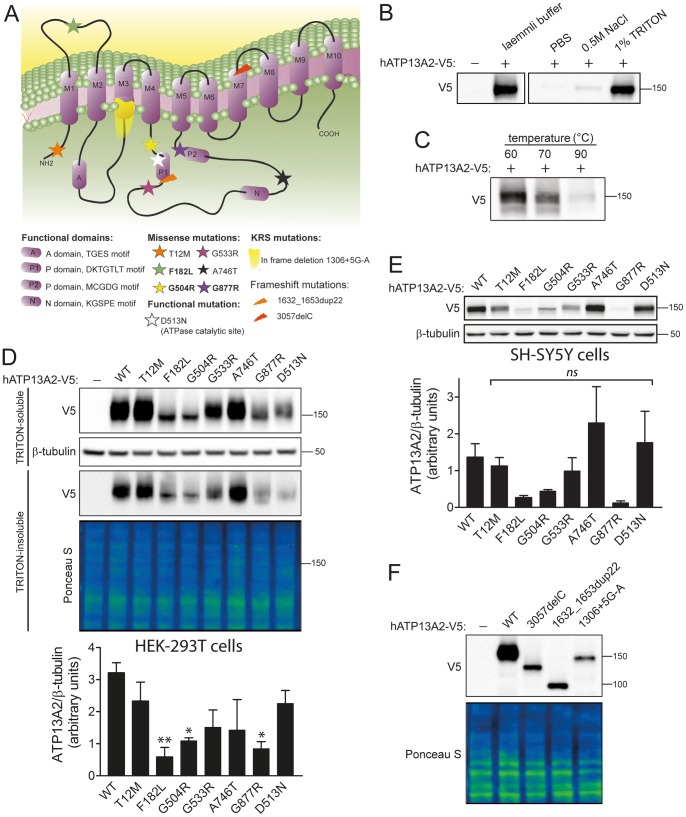
Disease-associated mutations reduce the steady-state levels of ATP13A2 protein. A
, Predicted domain topology model of human ATP13A2. Wild-type (WT) protein consists of ten transmembrane-spanning domains. The second intracellular loop contains the predicted catalytic ATPase domain comprising four functional domains (A, actuator domain; P1, catalytic phosphorylation site domain; P2 and N, nucleotide binding domains). Locations of disease-associated missense mutations are indicated by stars with homozygous variants in bold. KRS frameshift mutations are indicated by orange and red arrows, with an in-frame exon skipping mutation shown by yellow shading. B, Western blot indicating the buffer solubility of V5-tagged human ATP13A2 transiently expressed in HEK-293T cells. C, Western blot revealing the effect of increasing temperature on the solubility of V5-tagged human ATP13A2 in cell extracts obtained by lysis in 1% Triton X-100 buffer. D, Triton-soluble or Triton-insoluble (RIPA-soluble) fractions derived from HEK-293T cells transiently expressing WT or mutant V5-tagged human ATP13A2 were probed with anti-V5 antibody to monitor the steady-state levels of ATP13A2, or with β-tubulin antibody (or Ponceau S stain) to demonstrate equivalent protein loading. Densitometric analysis indicates dramatically reduced steady-state levels of F182L, G504R and G877R compared with WT ATP13A2 in the Triton-soluble fraction. Bars represent ATP13A2 levels normalized to β-tubulin (mean±SEM; n = 3–4 experiments) expressed in arbitrary units. E, Western blot analysis of the detergent-soluble fraction from SH-SY5Y cells transiently expressing WT or mutant V5-tagged ATP13A2. Densitometric analysis of ATP13A2 levels normalized to β-tubulin reveals reduced levels of F182L, G504R and G877R compared with WT ATP13A2 (mean±SEM; n = 3 experiments). F, Detergent-soluble extracts from HEK-293T cell transiently expressing WT and KRS mutant V5-tagged human ATP13A2 were probed with anti-V5 antibody, or β-tubulin antibody as a loading control. KRS mutants exhibit markedly reduced steady-state levels and produce truncations due to the loss of three (3057delC) or six (1632_1653dup22) C-terminal transmembrane domains, or the in-frame skipping of exon 13 (1306+5G→A) that removes half of the third transmembrane domain [5]. Molecular weight markers are indicated in kilodaltons (kDa). *P<0.05, **P<0.01 or non-significant (ns) compared to WT ATP13A2 by one-way ANOVA with Newman-Keuls post-hoc analysis.